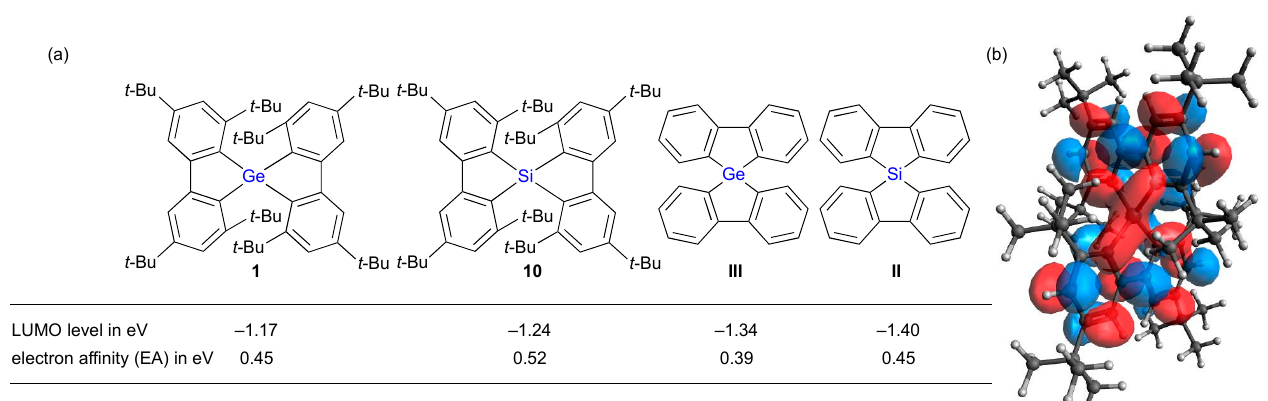
Figure 3. ( a ) Theoretically calculated LUMO levels and electron affinity (EA in eV) values for Si- and Ge-spirobifluorenes II , III , 1 and 10 . ( b ) LUMO of 1 ; all calculations were carried out at the B3PW91-D3(BJ)/6-311G(2d,p) level of theory.